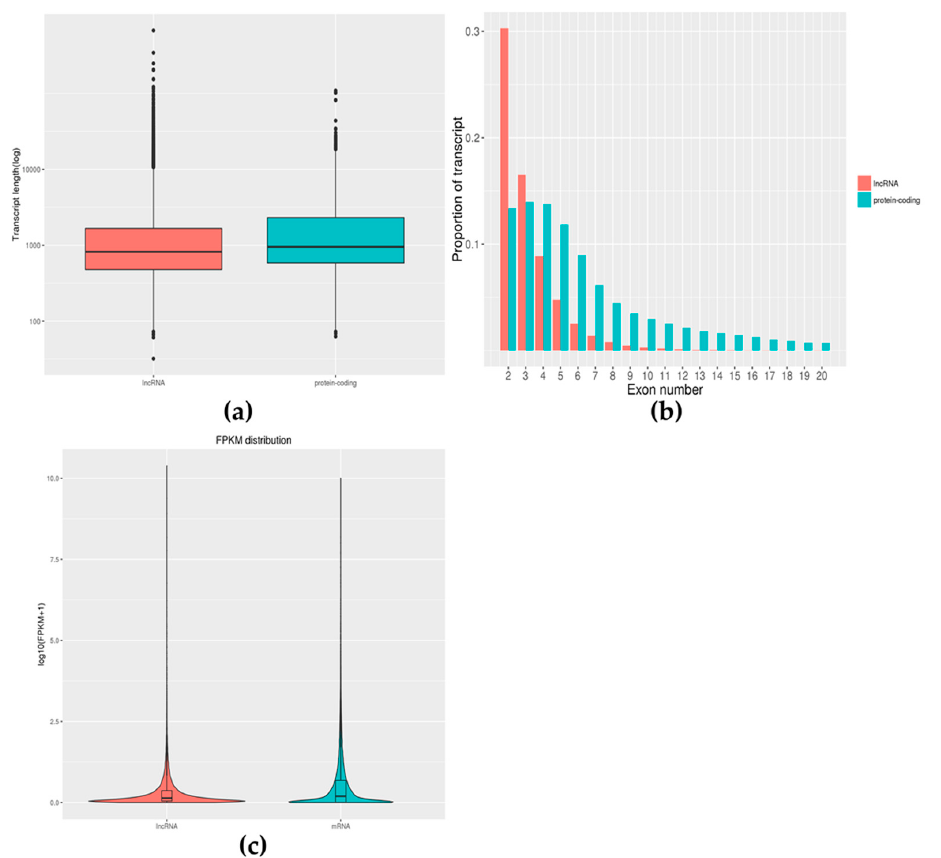
Figure 4. Feature comparison of lncRNA with mRNA. Comparative analysis of the length distribution of lncRNA and mRNA was performed and we found that lncRNA was slightly shorter than the mRNA ( a ). Comparative analysis of exon numbers of lncRNA and mRNA was performed and we found that mRNAs contained a larger range of exons ( b ). The expression values of lncRNAs and mRNAs were averaged separately and the box pattern was plotted with the values of both log10 (FPKM + 1) ( c ). Comparing the expression levels of lncRNAs and mRNAs, it was found that there was a difference in the expression levels of the two.